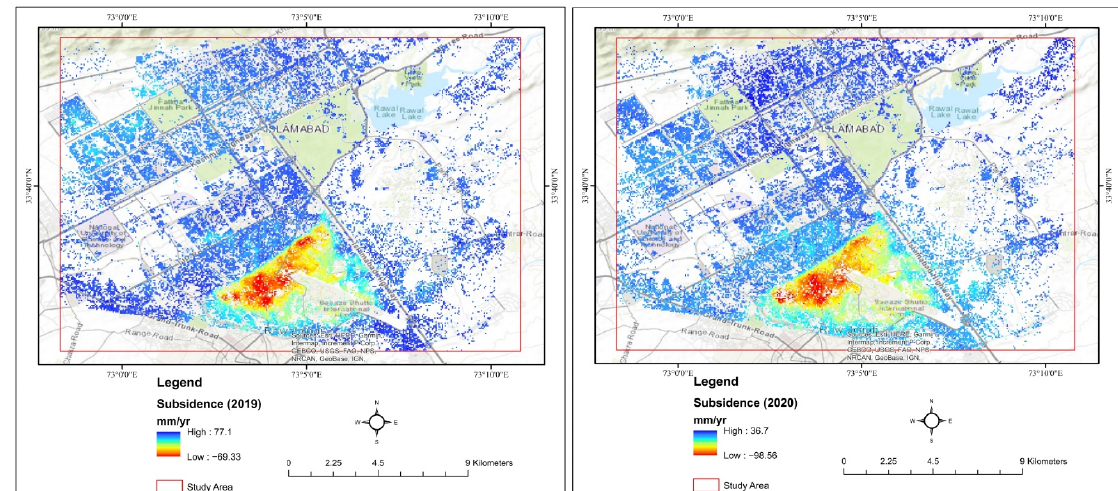
Figure 10. Comparison between subsidence values from the year 2019 to 2020. Five PS spots (a, b, c, d, and e) from the subsidence zone were selected from the research area’s ascending and descending findings (Figure 11). In this scenario, the PS points indicate the relative displacement and stability (red = severe, blue = stable, yellow = minimal) compared with the surroundings. Subsidence analyses and these five PS positions are shown in Figure 12.